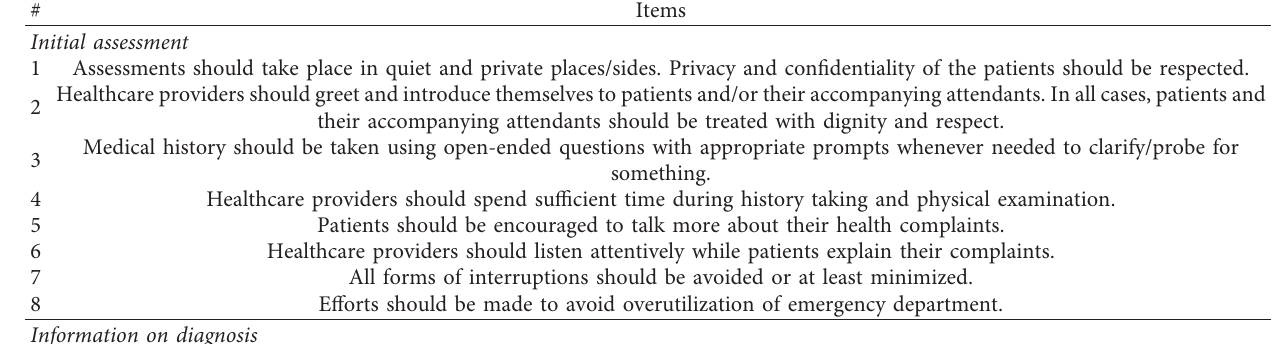
Table 1: Items guiding discharge communication with patients presenting to the emergency department with chest